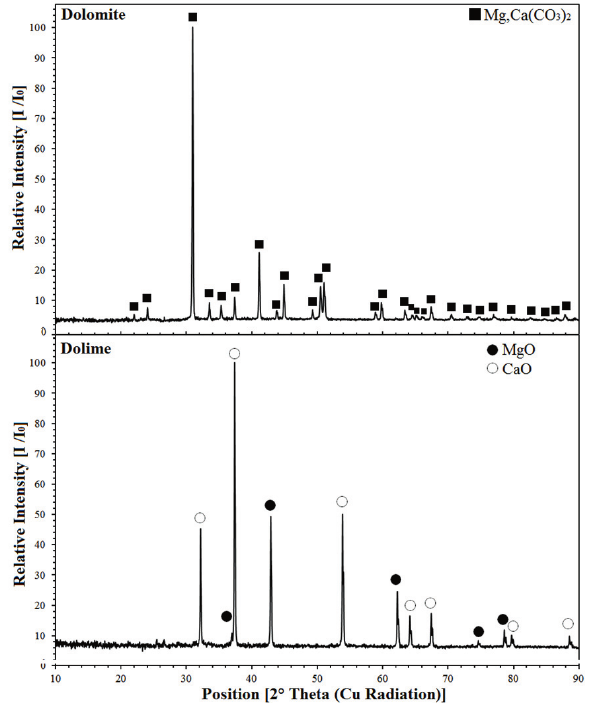
Figure 9. XRD diffraction of dolomite (before calcination) and dolime (after calcination).